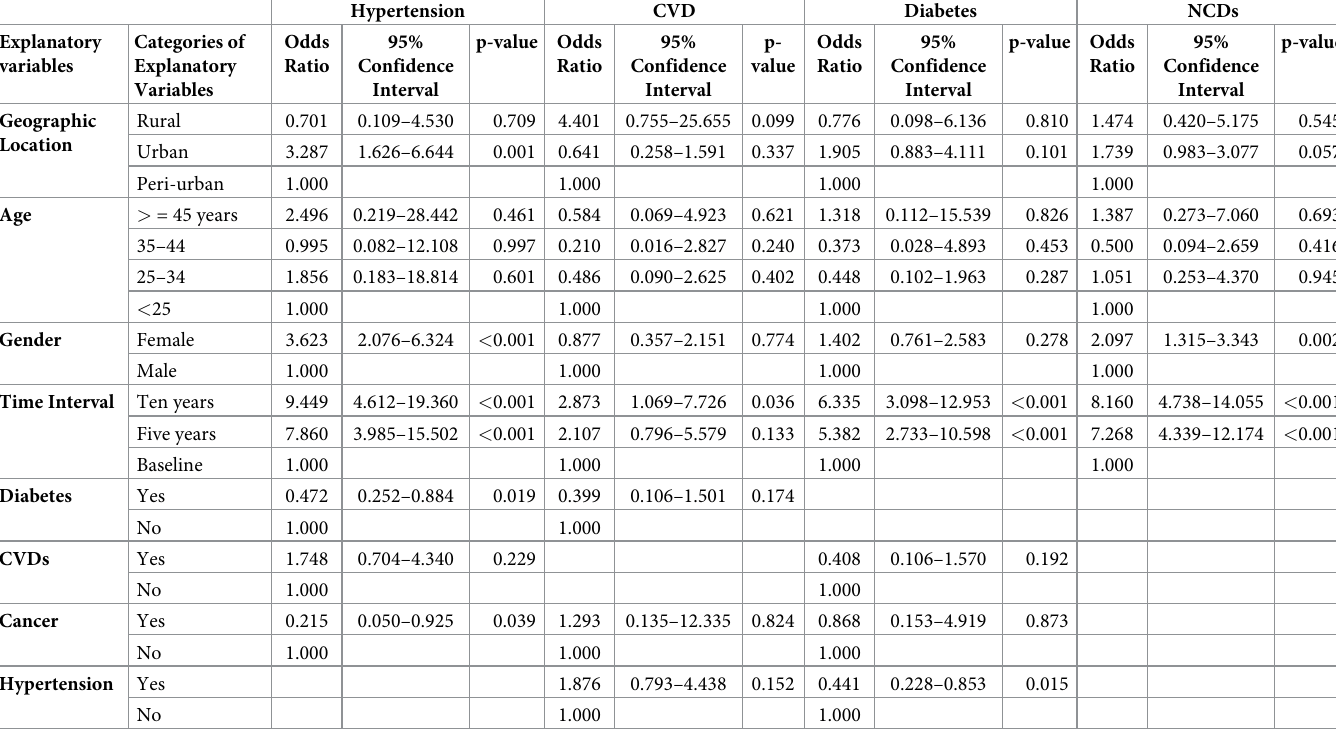
Table 2 shows that participants who resided in urban areas were 3.287 times more likely to develop hypertension when compared to those who resided in peri-urban locations (p- value = 0.001). However, participants from rural areas were about 30% less likely to develop hypertension as compared to peri-urban participants. Similar observations were obtained for Table 2. Odds ratios for risk factors associated with NCDs using generalized estimating equations. Hypertension CVD Diabetes